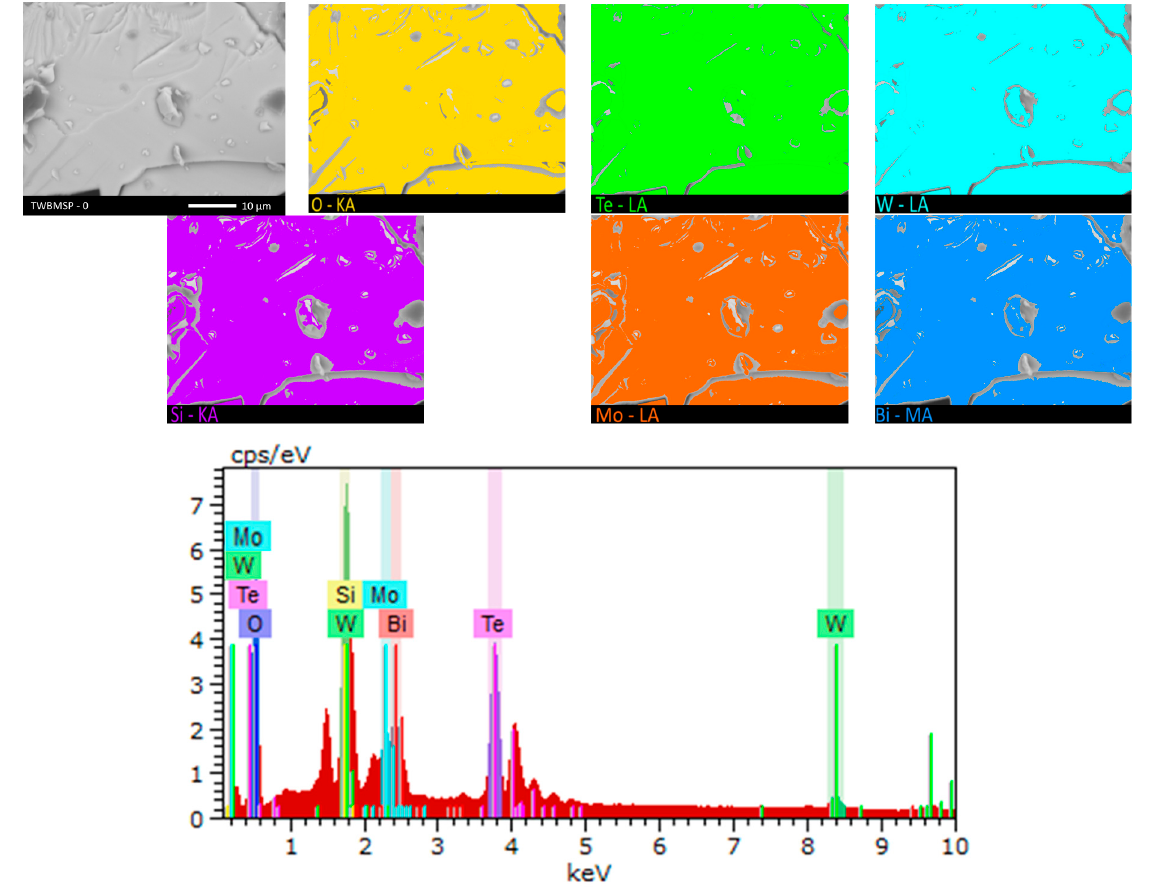
Figure 3. Mapping results for TWBMSP-0.